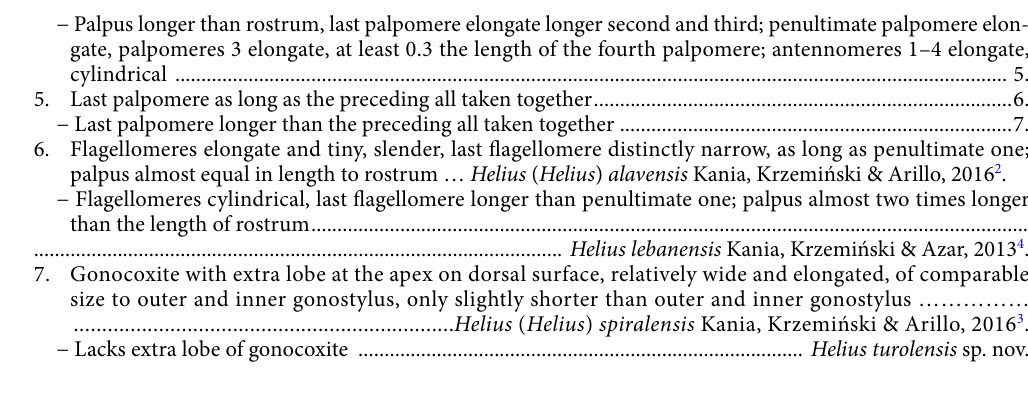
Figure 1. Helius turolensis sp. nov. No. 53–10-54 (male), holotype. ( A ) head (lateral view), reconstruction; ( B ) wing; ( C ) the diagram illustrating the relationship between the length of rostrum (r), antenna (a); palpus (p) and head (h); D. hypopygium (dorsal view), reconstruction; Abbreviation of head (h): a—antenna; fl—flagellomeres; pl—palpus; ped—pedicel; r—rostrum;